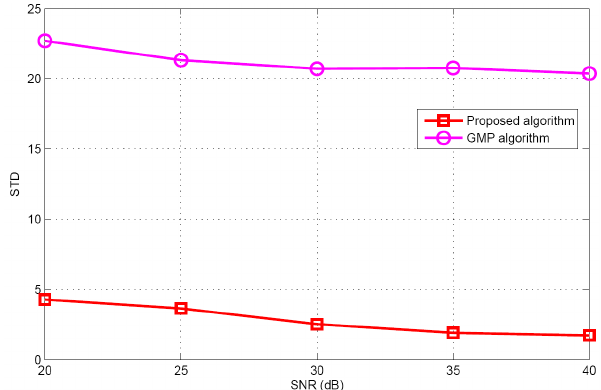
Figure 11. The STD of the estimated population versus SNR.